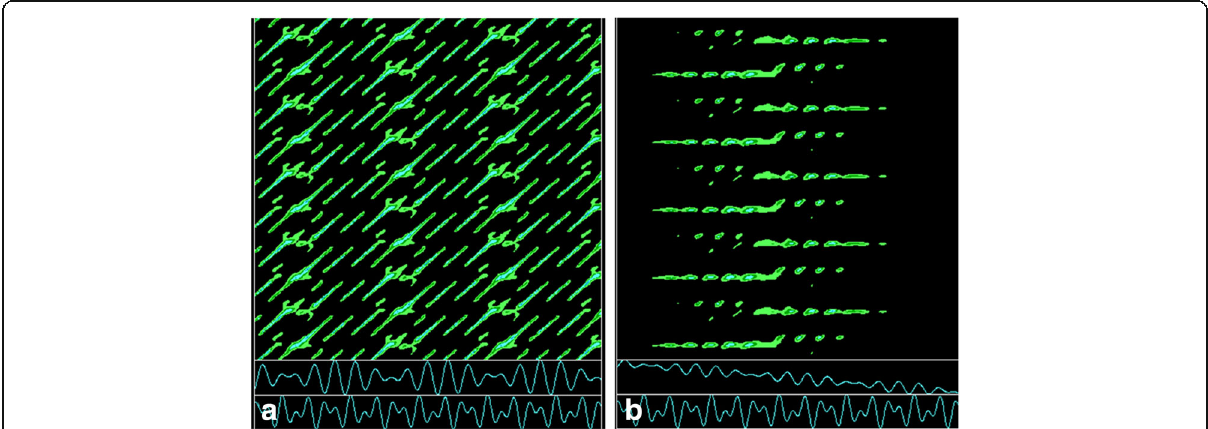
Fig. 10 The influence of a linear trend on a cross recurrence plot. a Cross recurrence plot for y = sin( x ) + sin (11 x /9) (top frame) against y = cos( x ) + sin (5 x /3) (bottom frame). b Cross recurrence plot of y = sin( x ) + sin (11 x /9) − 0.1 x (top frame) against y = cos( x ) + sin (5 x /3) (bottom